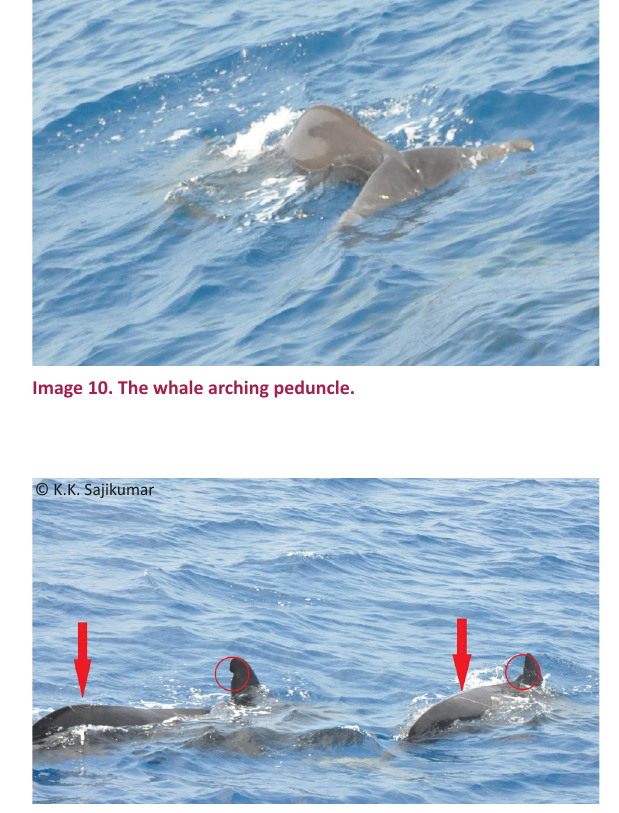
Image 12. Whale body had notch and injuries. Arrow marks indicate injuries and circle indicate